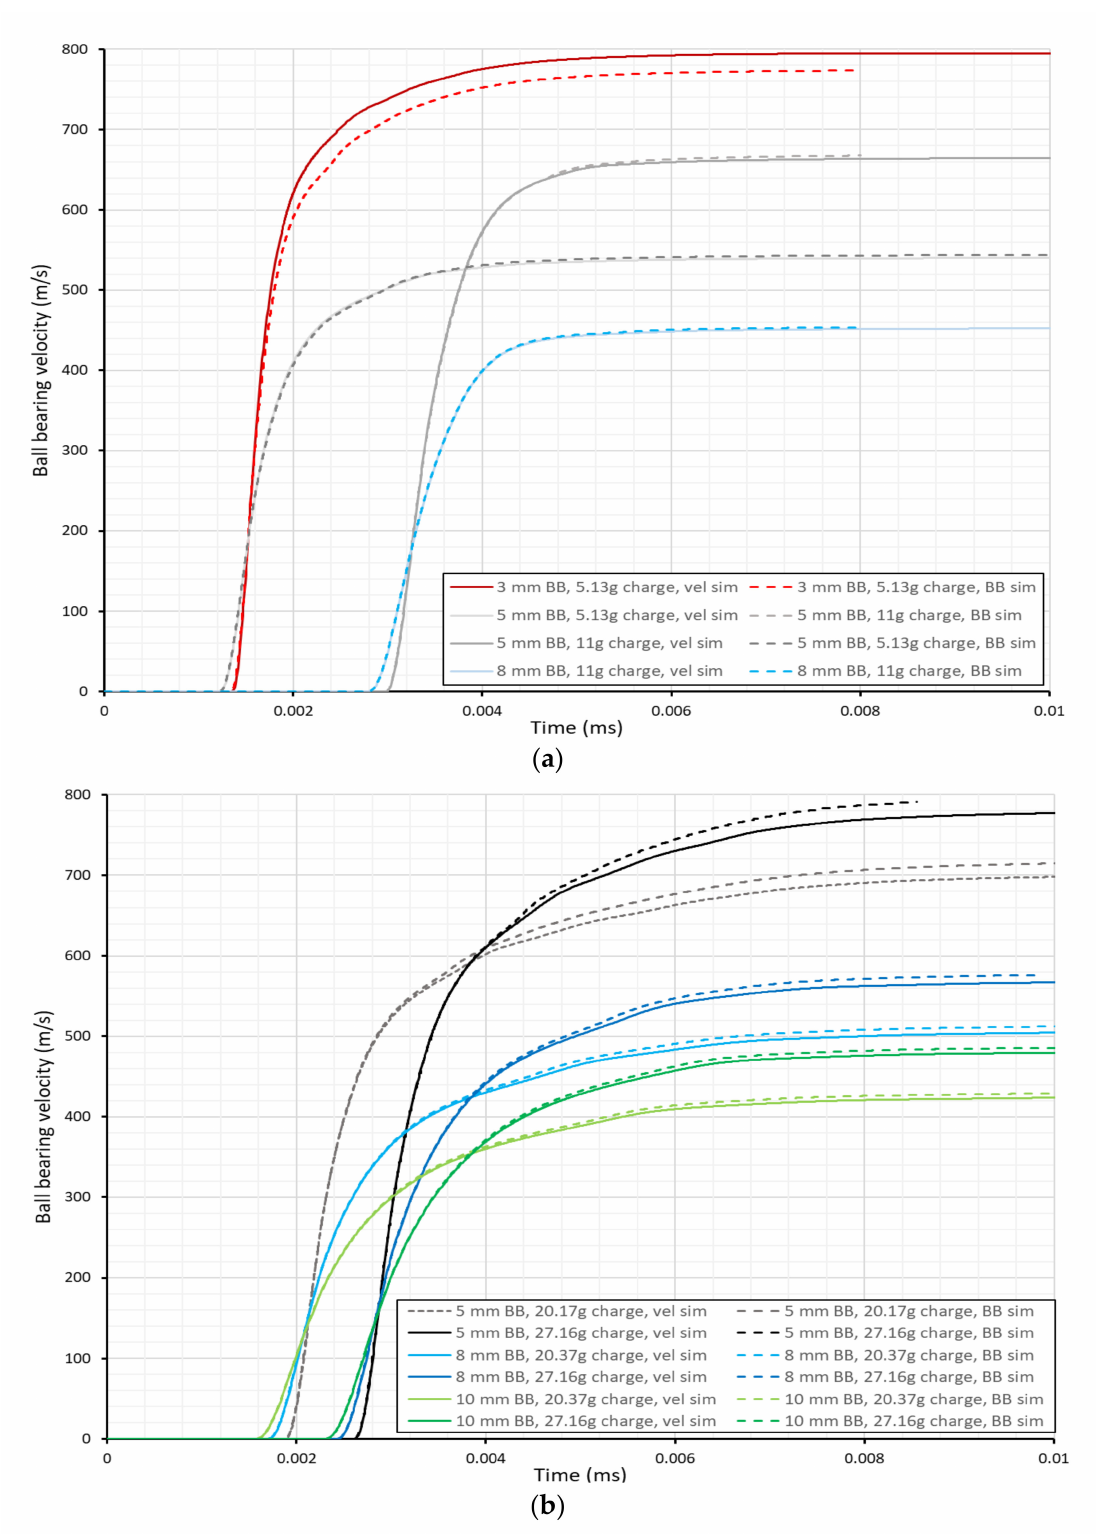
Figure 5. Ball bearing velocity–time histories for the first 10 µ s, comparing the velocity simulation ap- proach and the ball bearing simulation approach. ( a ) 18 mm diameter charge detonations, ( b ) 30 mm diameter charge